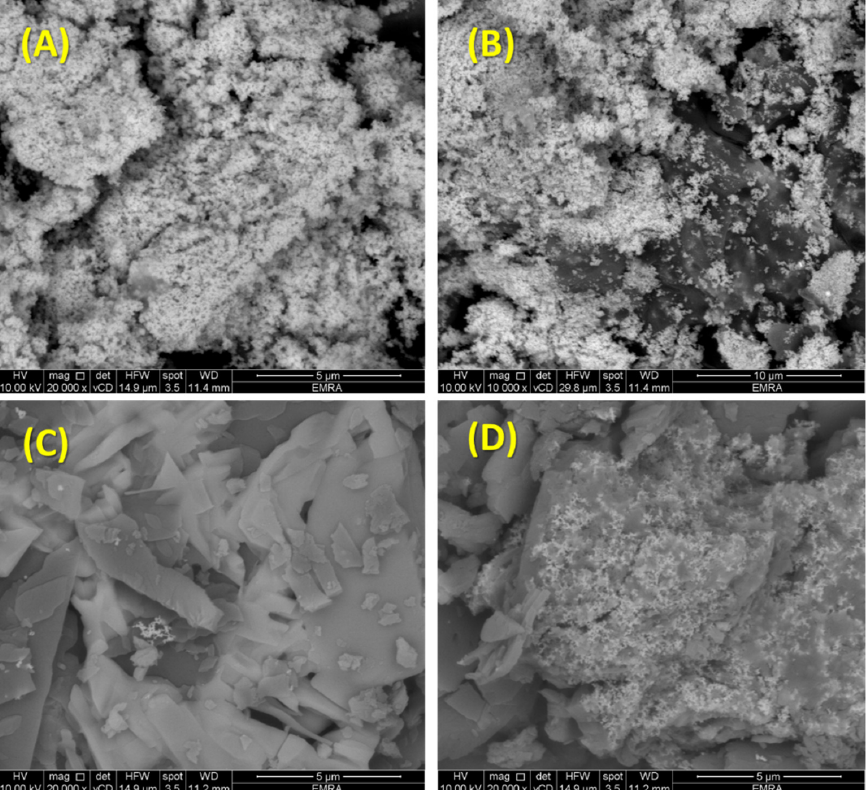
Figure 3. Representative SEM micrographs of the [Au(sec) 2 Cl] ( A ) [Pt(sec) 2 ]; ( B ) [Pd(sec) 2 ]; ( C ) and [Ag(sec)]; ( D ) complexes. [Ag(sec)]; ( D )